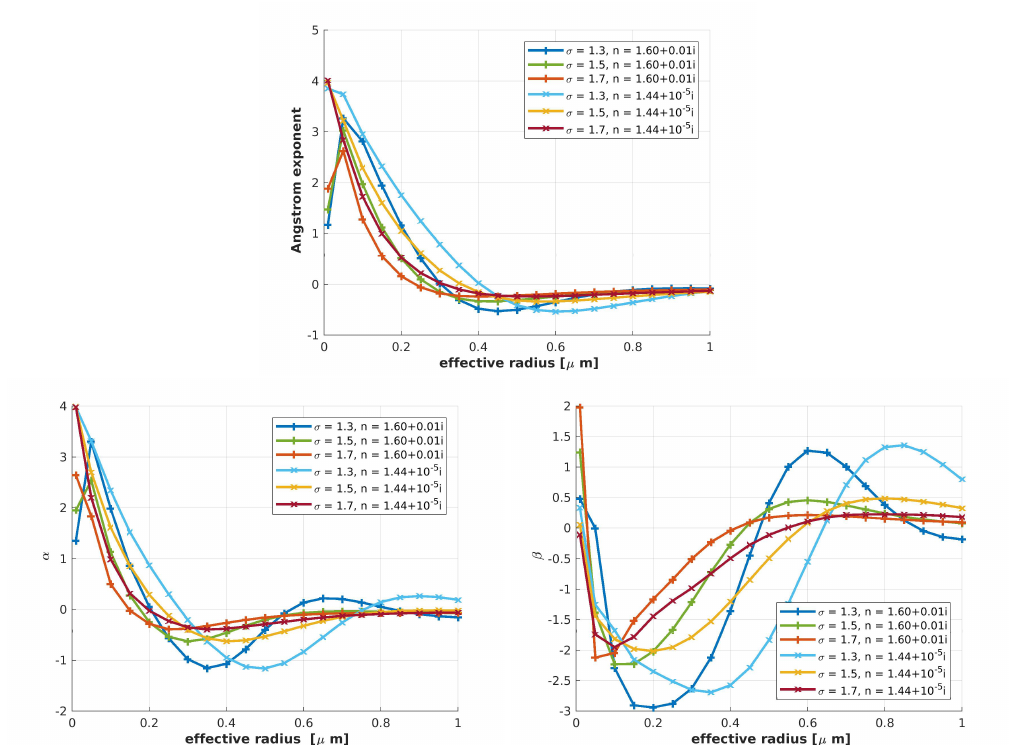
Figure 4. Radius dependency of the traditional and modified Ångström exponent AE , α , and β for different refractive indexes and standard derivations σ